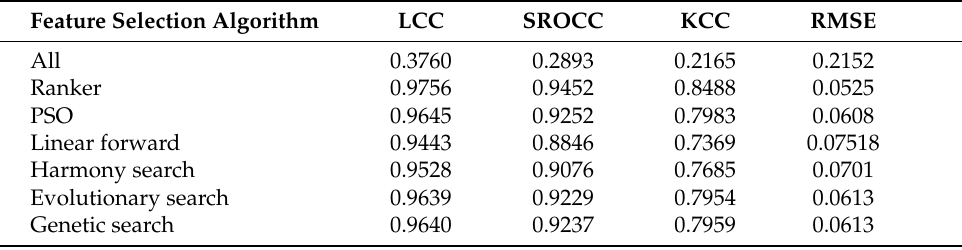
Table 2. Performance comparison of feature selection